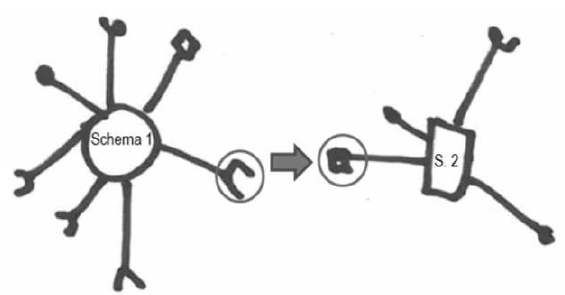
Figure 2. Cartoon of two schemata with fitting connection/docking features